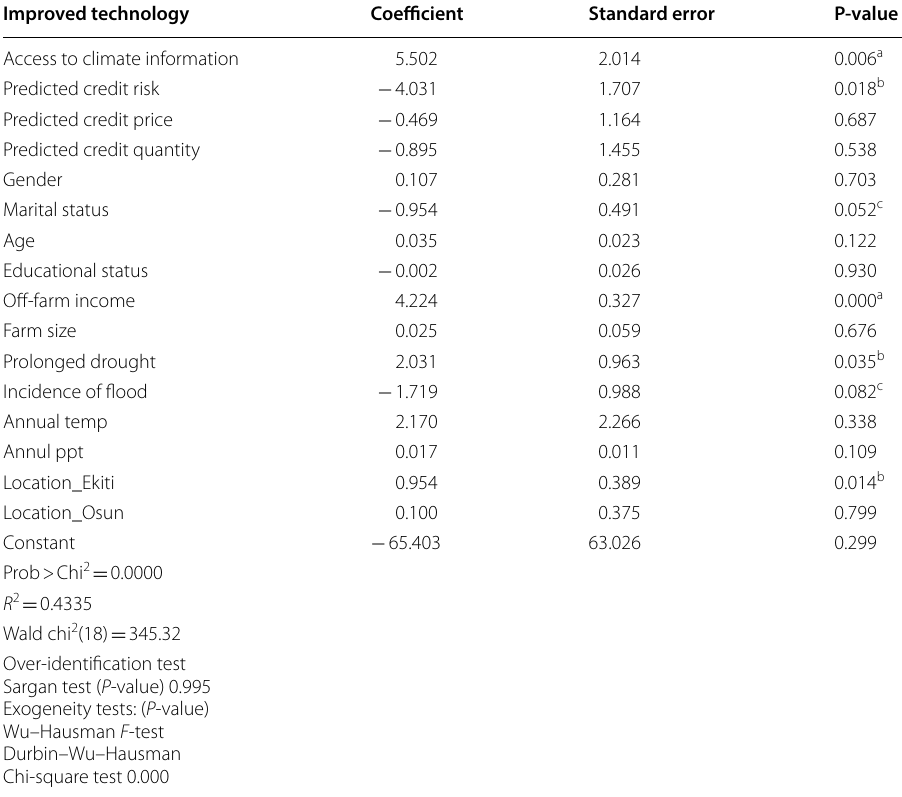
a, b, c Represent significance level at 1%, 5% and 10%, respectively; Std. Err is a robust standard error; Location_Ondo was used as the base